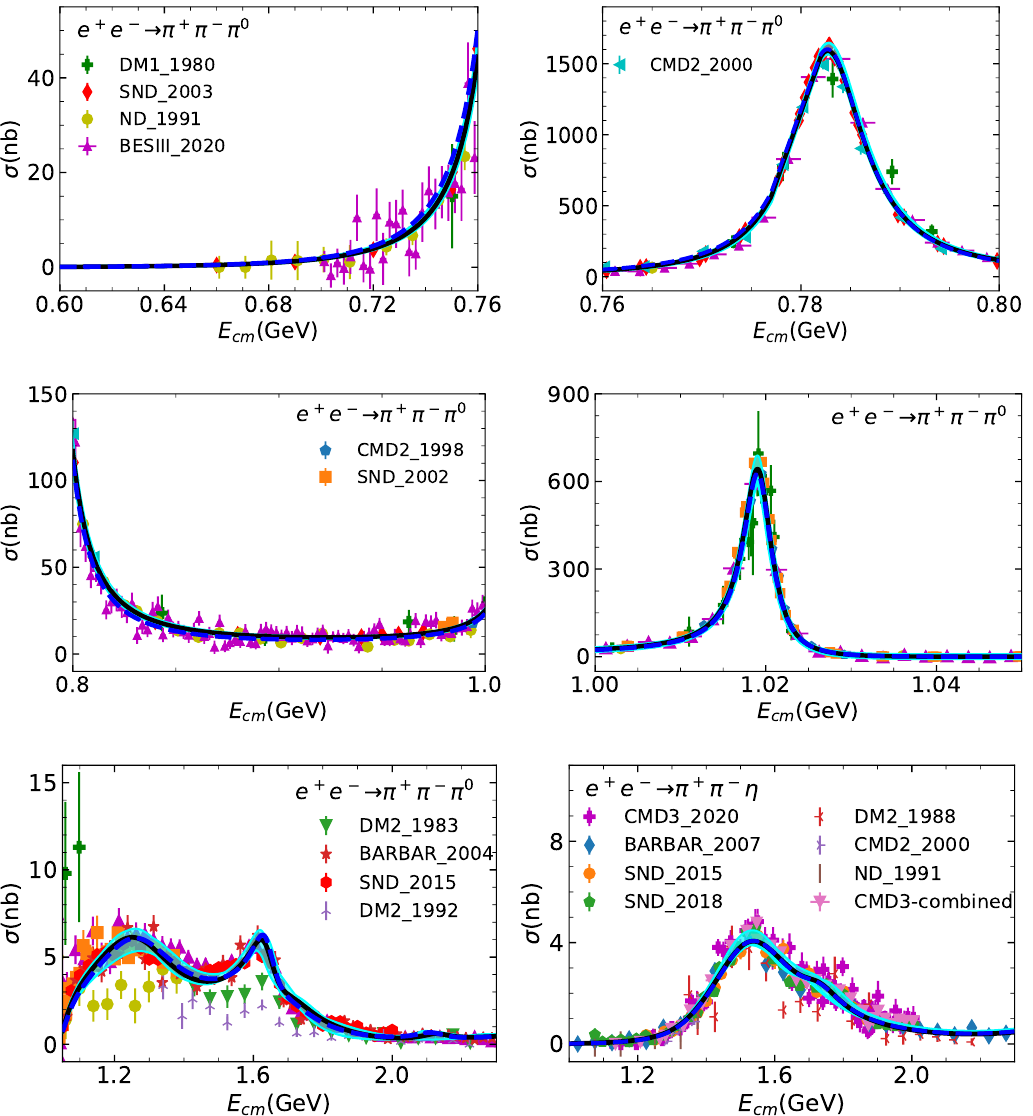
Figure 1 . Fit to the cross sections of e + e − → πππ, ππη of Fit I (dashed blue line) and Fit II (solid black line). The cyan bands corresponds to the uncertainty of Fit II. The last graph is about ηππ channel and the others for πππ . The experimental data displayed for e + e − → πππ are from DM1 [97], ND [98], DM2 [99], CMD2 [100–102], SND [63, 103, 104], Babar [105], and BESIII